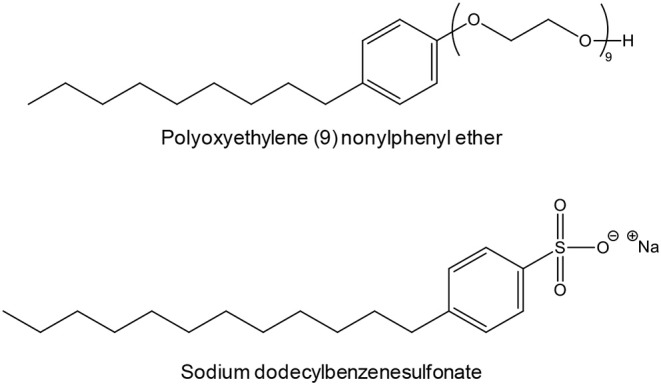
Examples of surfactants employed by Wang et al. to synthesize Y2O2S:Eu in molten NaCl (Wang et al., 2014).